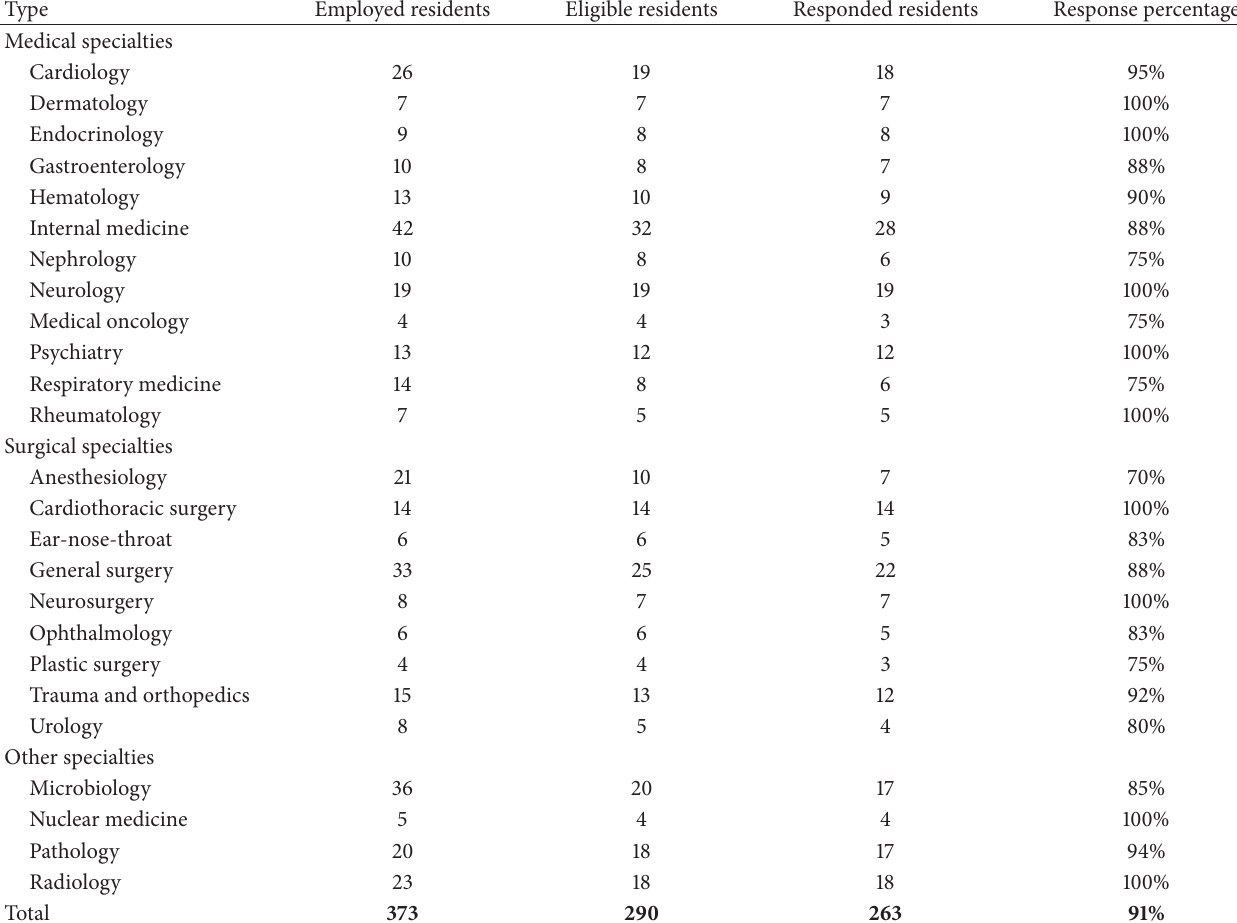
Table 1: List of specialties included in the study with the corresponding eligible residents and their response rates, grouped by category. Type